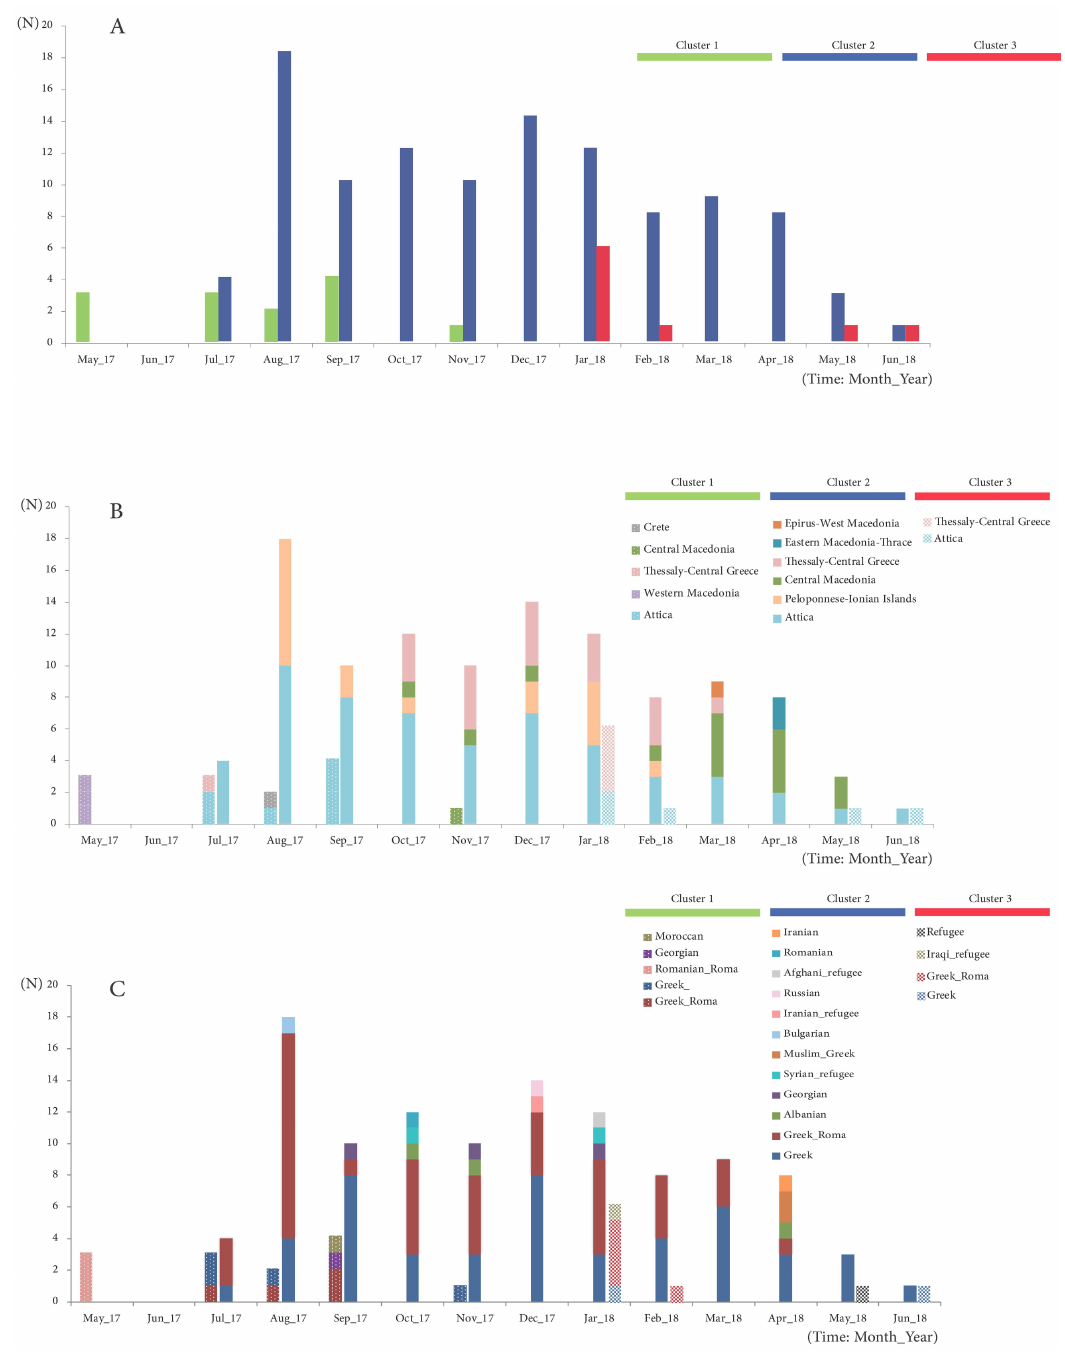
Figure 3. Epidemic curves of ( A ) the 3 main circulating clusters of the 2017–2018 MeV epidemic in Greece, broken down according to ( B ) origin (administrative regions of Greece) and ( C ) demographic characteristics of the infected individuals.